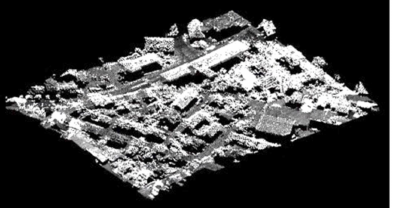
Figure 8. 3D perspective view of the LiDAR data shown in Figure 7b.